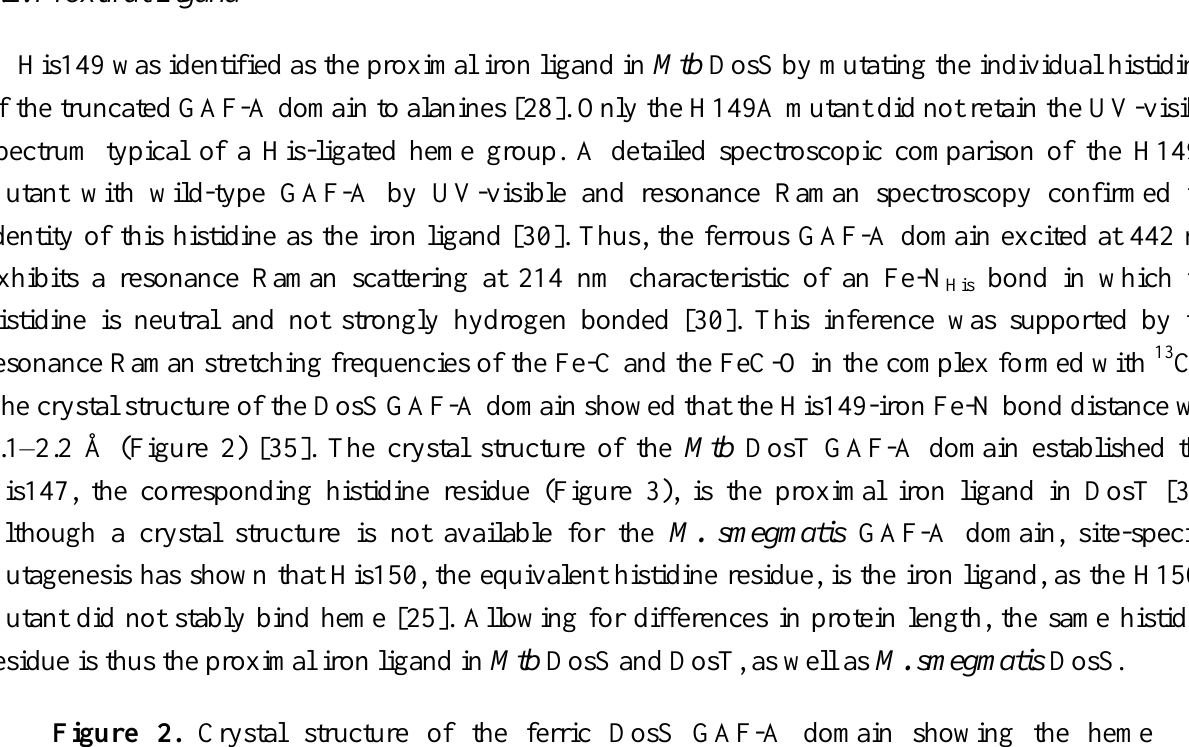
Figure 2. Crystal structure of the ferric DosS GAF-A domain showing the heme surrounded by the hydrophobic residues in a ligand binding pocket. The heme iron is coordinated to His149 to the proximal side and the distal water molecule is hydrogen bonded to the Tyr171 residue, which interacts with the His89 via Glu87 [35]. Reprinted with permission. © 2008 The American Society for Biochemistry and Molecular